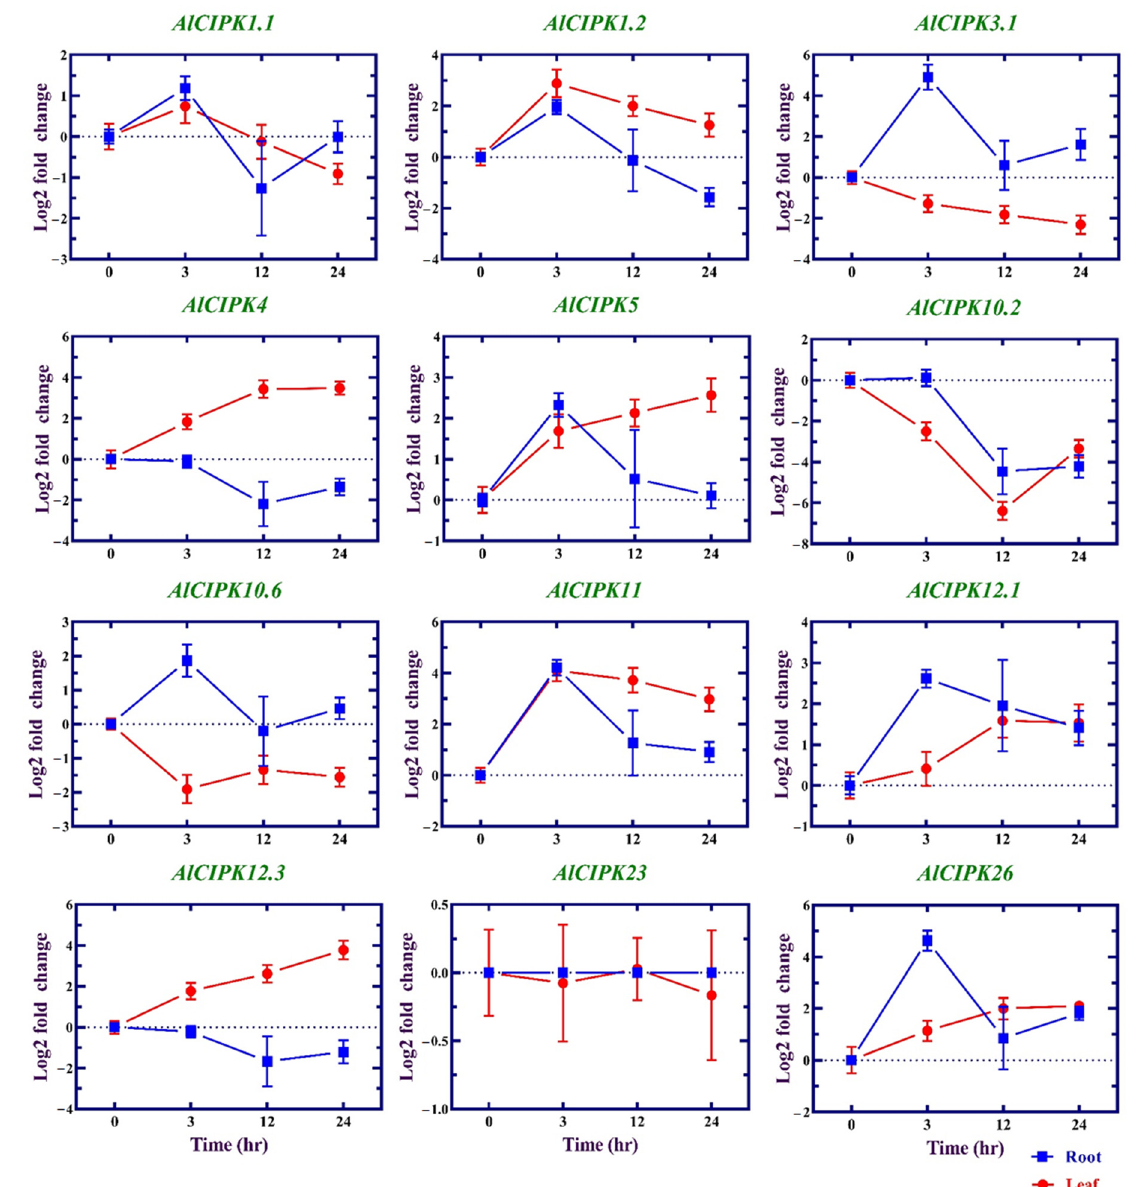
Figure 7. Expression patterns of AlCIPK genes in response to salinity in two tissues root and leaf. Expression levels are presented based on log2 fold change stress/normal condition.